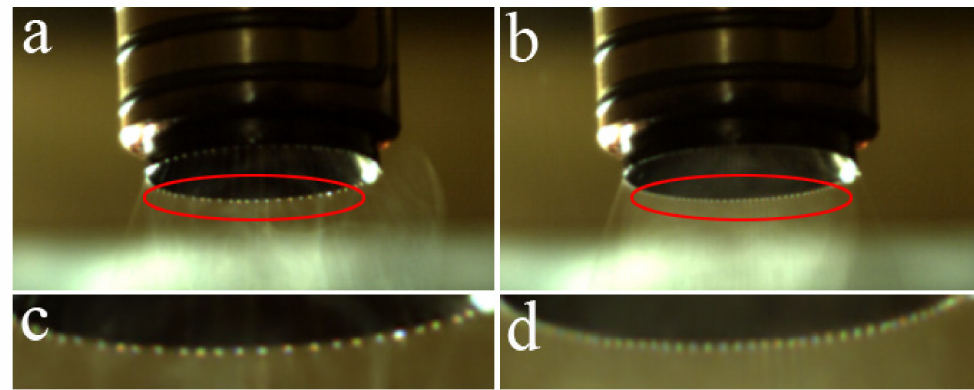
Figure 7. Overall and partial enlarged photosof jet distribution after self-organization when the spinning voltage is 35 kV ( a , c ) and40 kV ( b , d ).